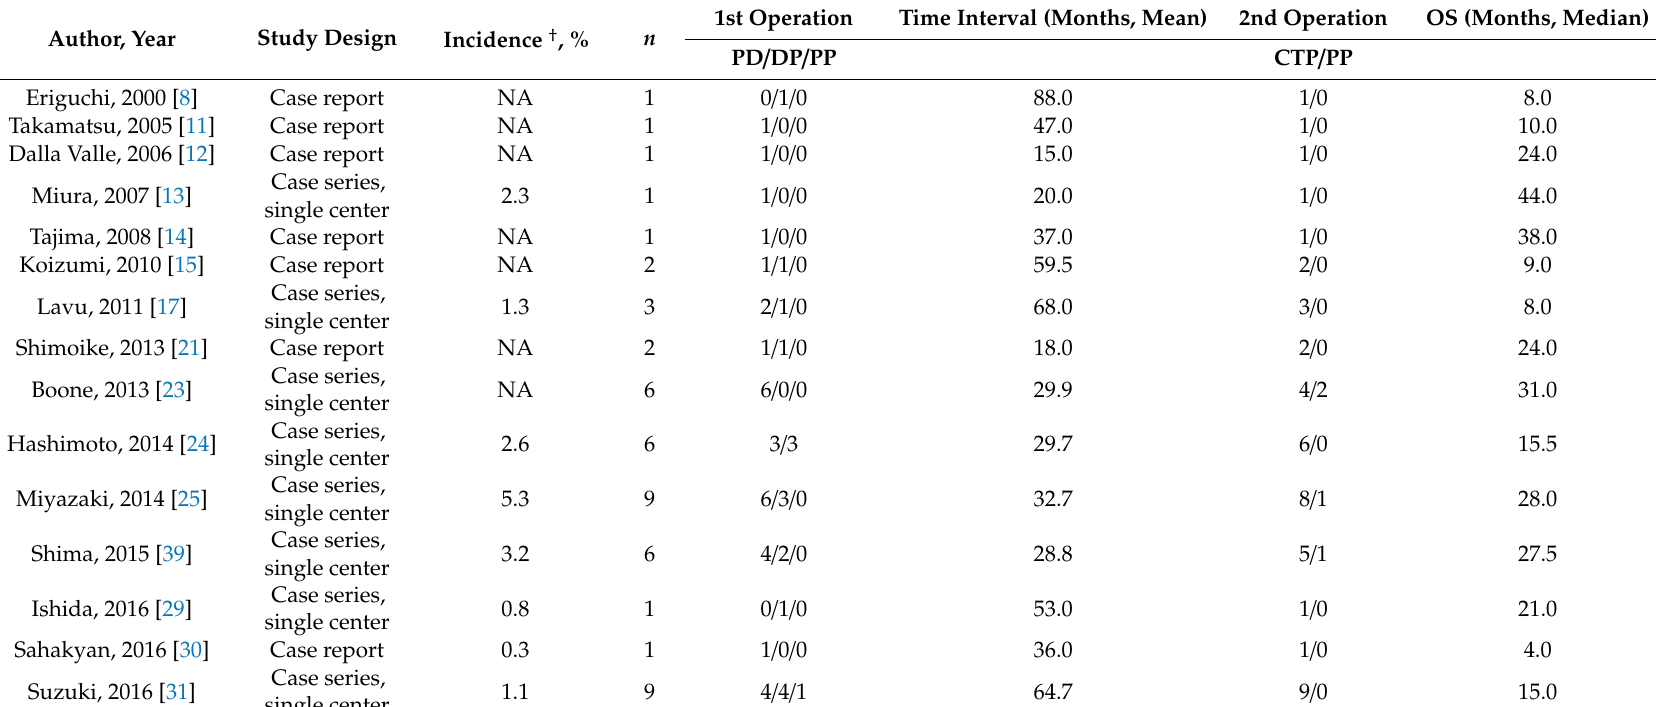
Table 1. Characteristics of the selected